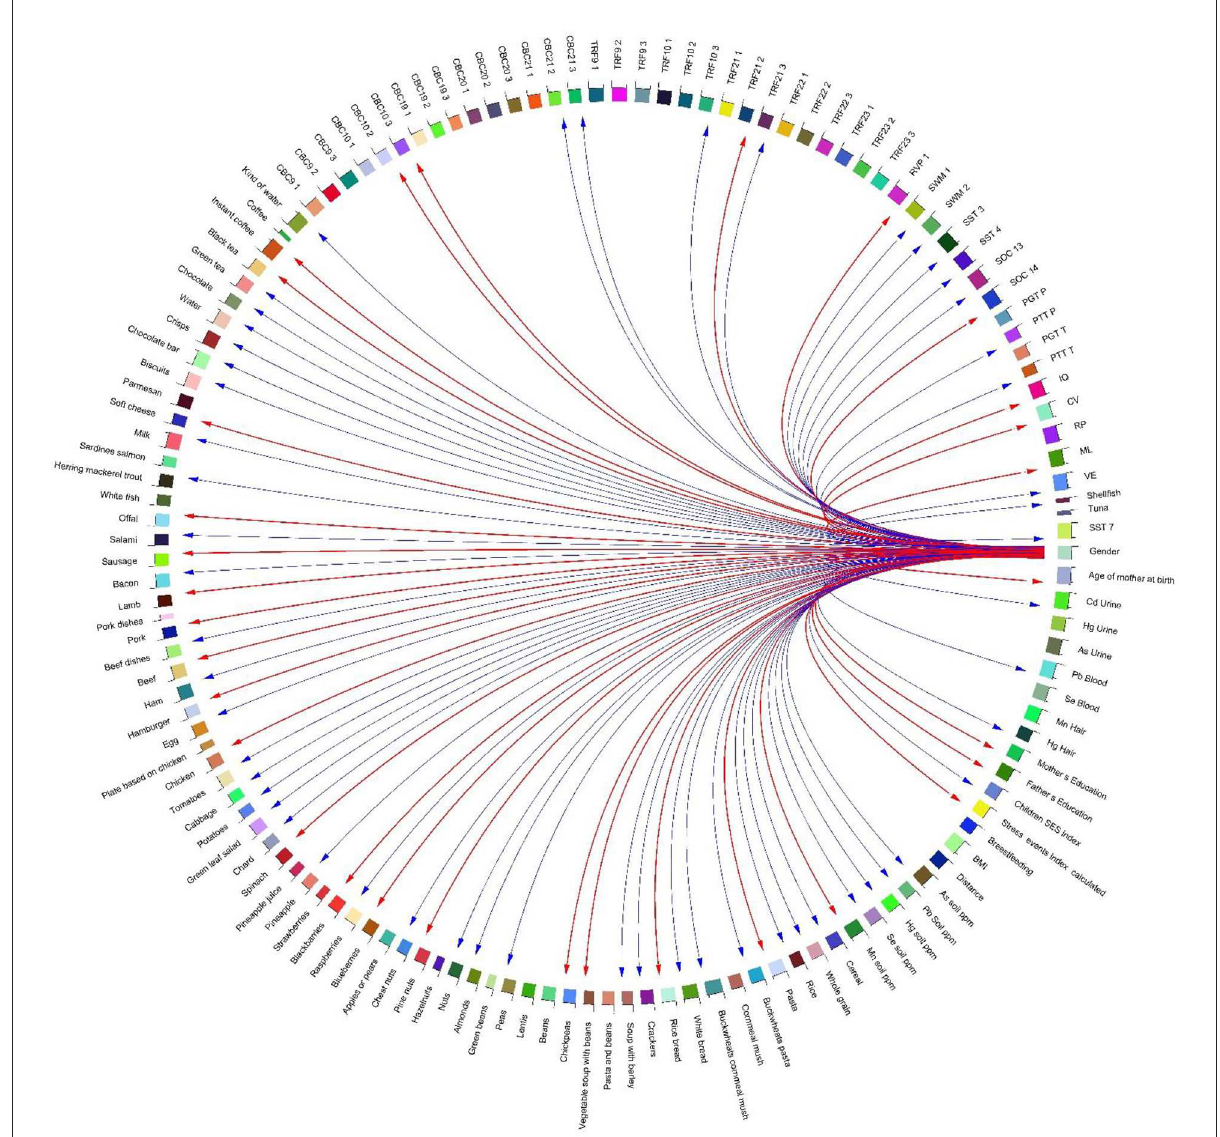
FIGURE13 Correlation globe of exposure factors and health outcomes for the children participated in HERACLES cohort. Our study revealed significant associations between the conjoint behavioral consultation (CBC) indices and exposure to metals [for example the Attention Deficit/Hyperactivity Problems index was negatively correlated with exposure to Hg ( p -value = − 0.03)]. No significant relationships were found between exposure factors and TRF